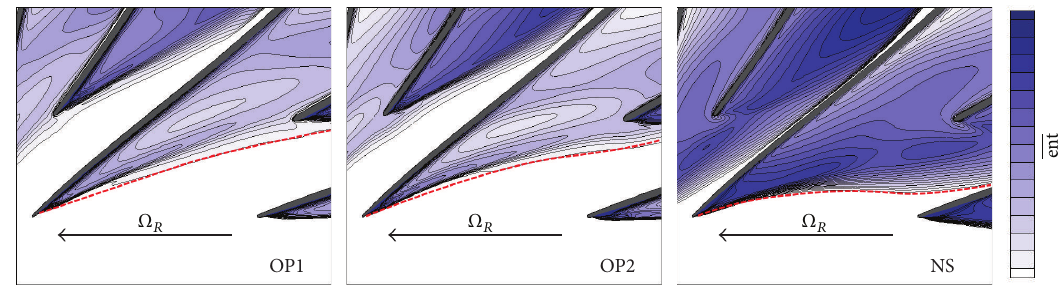
Figure 10: Time-averaged entropy contours at the blade tip (98% span) in the inducer for the three operating